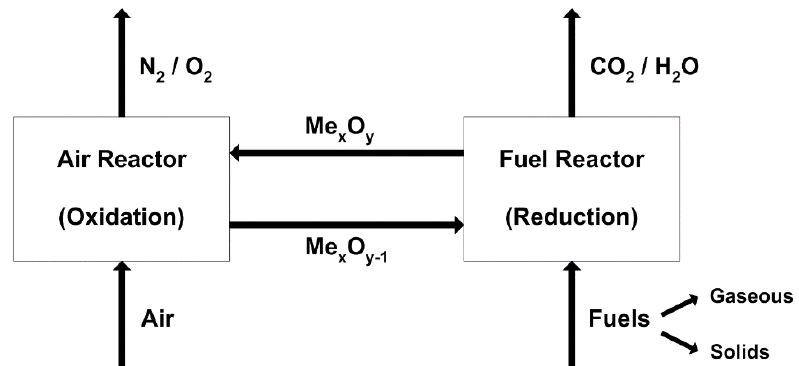
Figure 1. Schematic of the chemical-looping combustion process, which is a cycling process that consists of a fuel reactor and an air reactor